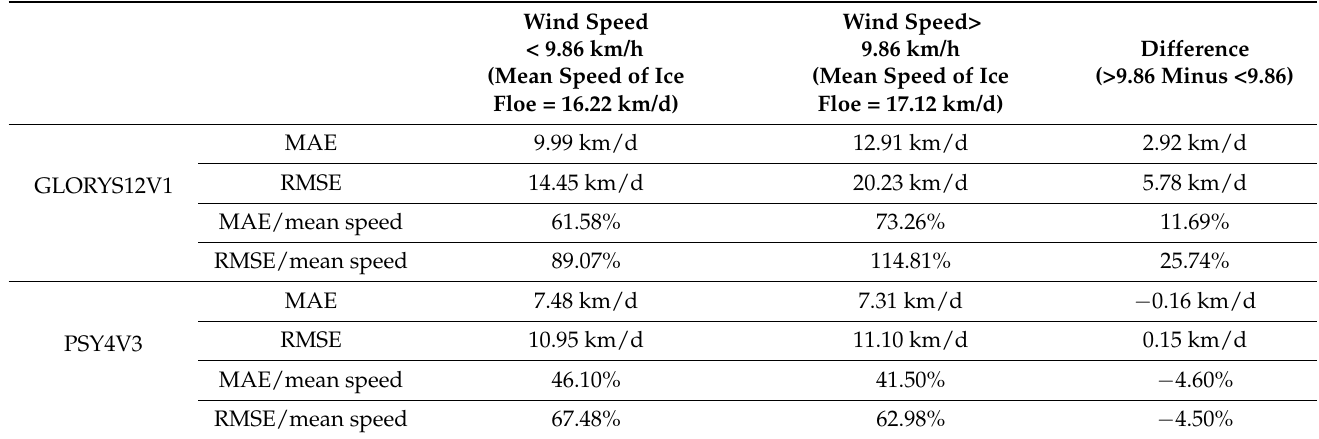
Table 4. Accuracies of the sea ice motion products under the two wind speed regimes separated by the median wind speed of 9.86 km/h. Wind Speed < 9.86